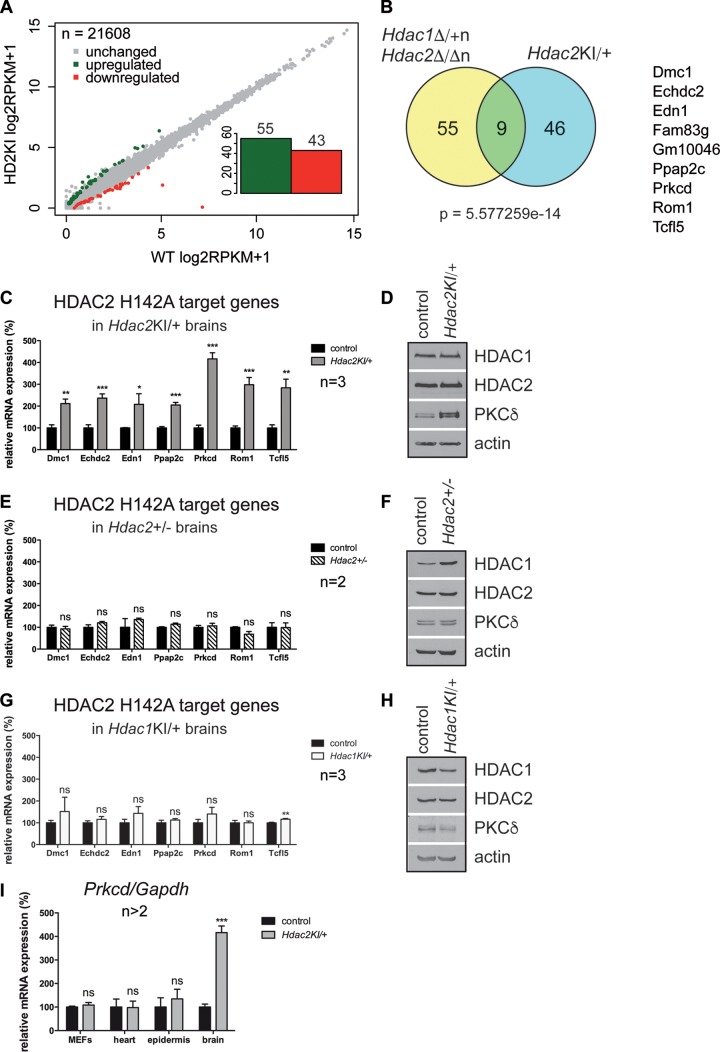
Transcriptional derepression and upregulation of protein kinase C delta in Hdac2KI/+ brains. (A) Changes in mRNA abundances of 21,608 RefSeq genes upon heterozygous expression of HDAC2-H142A in P0 Hdac2KI/+ brains determined by full-length mRNA-seq (3 Hdac2KI/+ brains versus 3 wild-type control littermate brains at P0). (B) Venn diagram of upregulated genes (fold change of ≥2; P value of <0.05) in Hdac1Δ/+n
Hdac2Δ/Δn brains (yellow) (9) compared to Hdac2KI/+ brains (blue). The overlap (green) includes the 9 genes shown on the right. The P value (5.6 × 10−14) was calculated by using a hypergeometric test. (C, E, and G) Relative mRNA expression levels of Dmc1, Echdc2, Edn1, Ppap2c, Prkcd, Rom1, and Tcfl5 in P0 Hdac2KI/+ brains (C), Hdac2+/− brains (E), and Hdac1KI/+ brains (G) compared to the corresponding wild-type littermate controls. Values are normalized to the values for the housekeeping gene Gapdh. Error bars indicate SD (n = 3 [C and G] and n = 2 [E]). *, P < 0.05; **, P < 0.01; ***, P < 0.001; ns, not significant. (D, F, and H) Immunoblot analyses of P0 wild-type littermate control versus Hdac2KI/+ brain extracts (D), Hdac2+/− brain extracts (F), and Hdac1KI/+ brain extracts (G), with antibodies against HDAC1, HDAC2, PKCδ, and β-actin, which was used as a loading control. (I) Relative mRNA expression levels of Prkcd in different Hdac2KI/+ tissues compared to the corresponding wild-type littermate controls. Values are normalized to the values for the housekeeping gene Gapdh. Error bars indicate SD (n > 2). ns, not significant; ***, P < 0.001. MEFs, mouse embryonic fibroblasts.